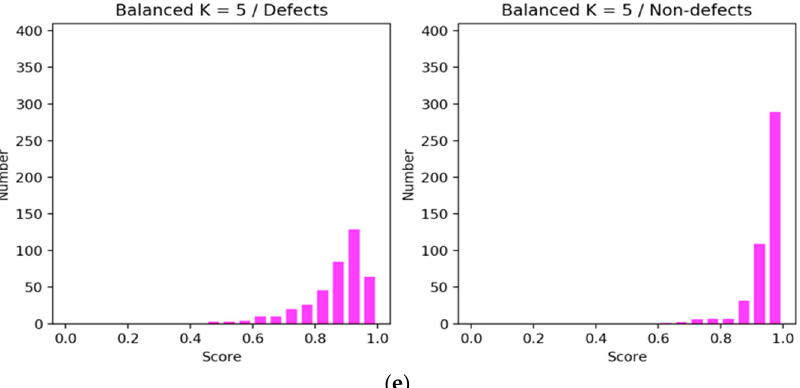
Figure 10. Performance comparisons of various numbers of clusters. ( a ) Imbalanced, ( b ) two clusters, ( c ) three clusters, ( d ) four clusters, and ( e ) five clusters.